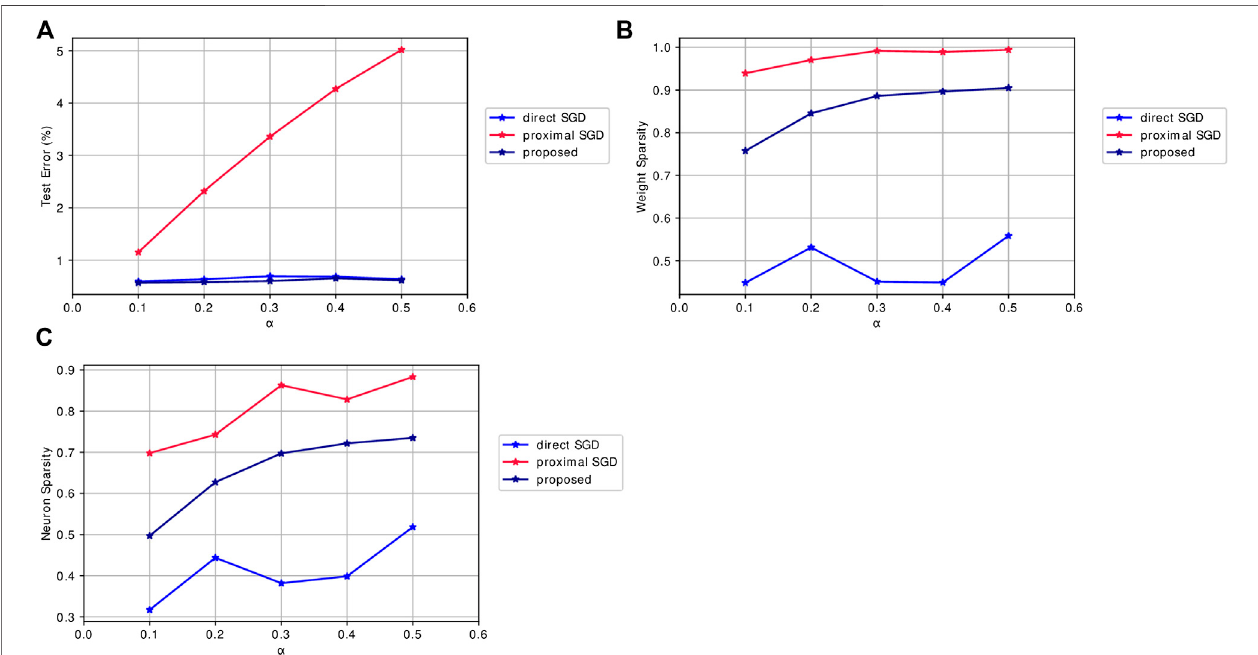
FIGURE 3 | Mean results of algorithms applied to SGL 1 for Lenet-5 models trained on MNIST with lowest test errors across 5 runs when varying the regularization parameter λ (cid:2) α / 60000 when α ∈ { 0 . 1 , 0 . 2 , 0 . 3 , 0 . 4 , 0 . 5 } . (A) Mean test error. (B) Mean weight sparsity. (C) Mean neuron sparsity.